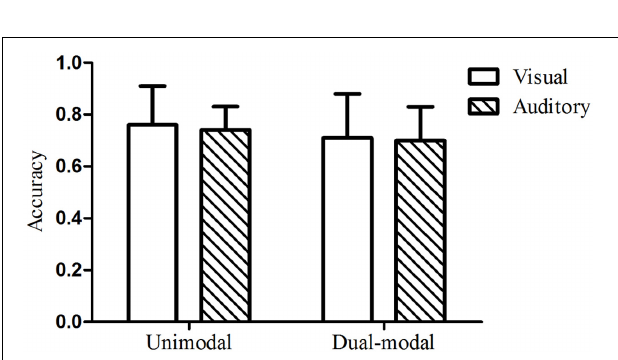
FIGURE 4 | Mean test accuracy under redundant dual-modality conditions (Experiment 2) compared to unimodal controls (Experiment 1). The error bars represented the standard deviation of the mean to the